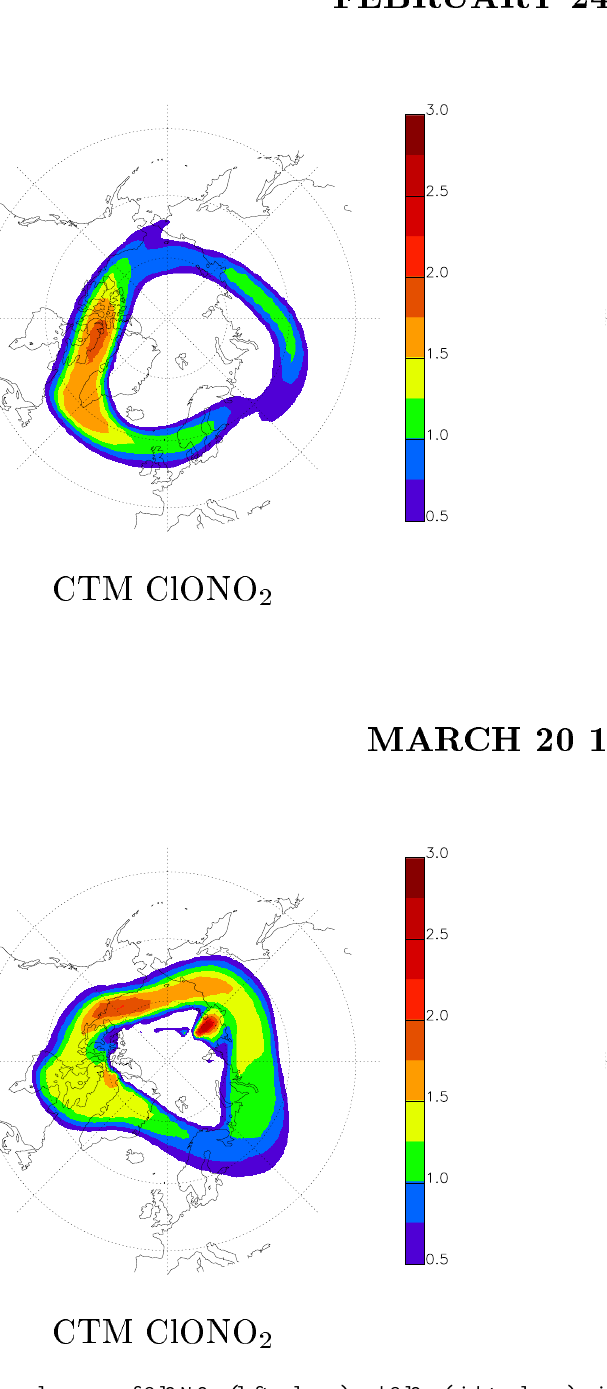
Fig. 4. False color maps of ClONO 2 (left column) and ClO x (right column) mixing ratio at about 45hPa, at 12:00UTC on 24 February 1997 (top row) and on 20 March 1997 (bottom row) as modelled with STRATAQ CTM. Values are in